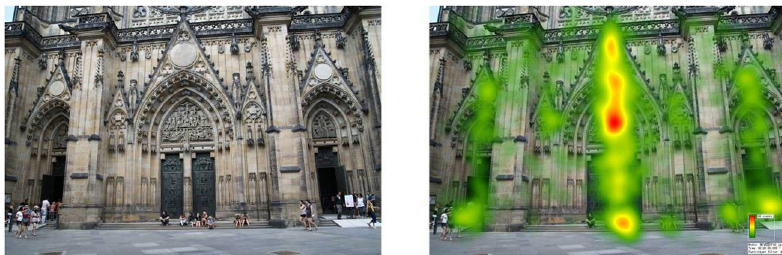
Fig. 14 The comparison of eye motion and heatmap for the Prague Castle façade.